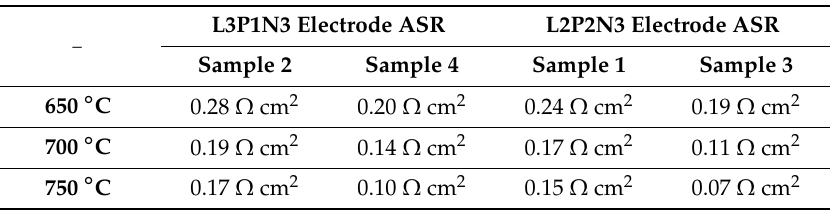
Table 3. Systematic improvement in half-cell performance on increasing Pr content across di ff erent compositions and improvement in ASR performance within a composition by reducing the e ff ective cell sintering time.